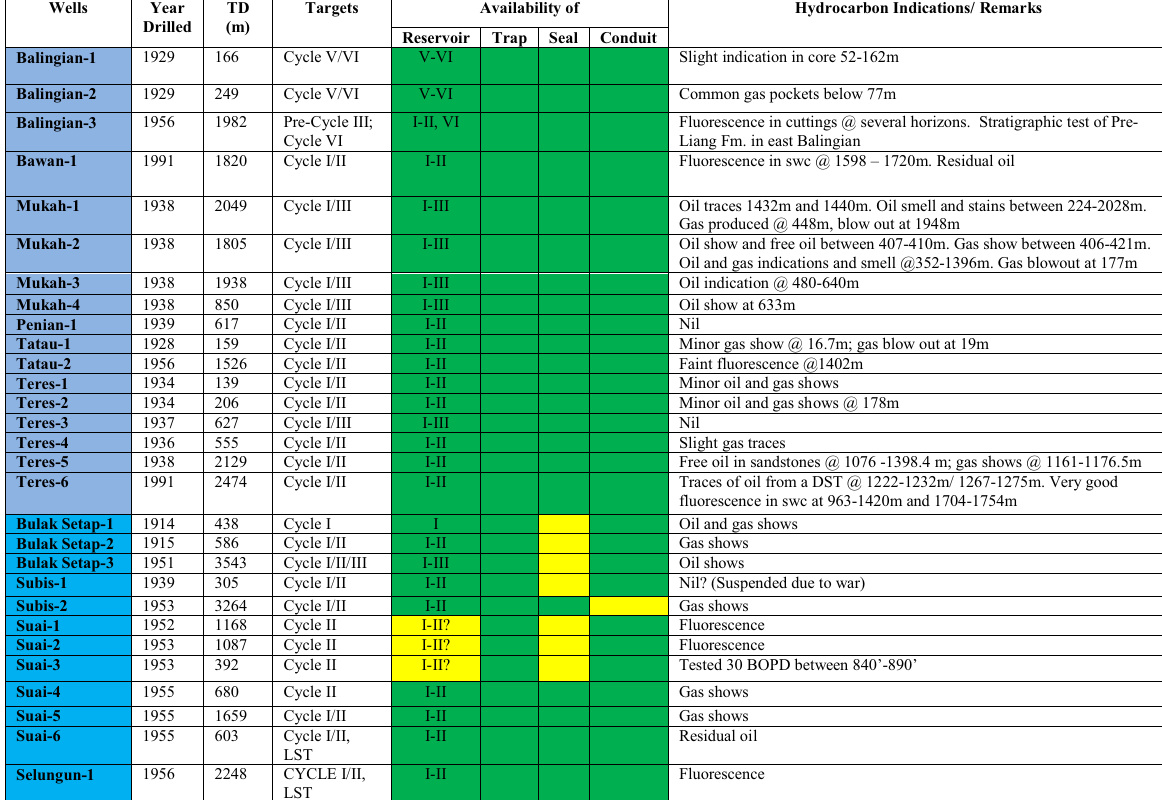
Table 1 Overview of hydrocarbon wells drilled in onshore Central Sarawak (modified from Madon and Abolins 1999; Mahmud et al. 2001)